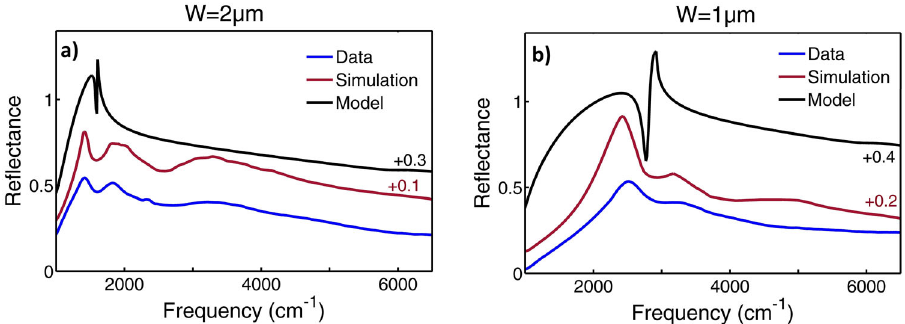
Fig. 3 Comparison among experimental (blue line), simulated (red line) and model (black line) re fl ectance of ribbon arrays with width W = 2 μ m and W = 1 μ m PdCoO fl ectances are shifted along the y-axis with an offset of 0.1 and 0.3 ( a ), and 0.2 and 0.4 ( b ), respectively. The 2 . Model and simulated re dip in the re fl ectance spectra is related to plasmon excitations at the PdCoO 2 – sapphire interface, the broad minima at a higher frequency to the PdCoO 2 – air interface.